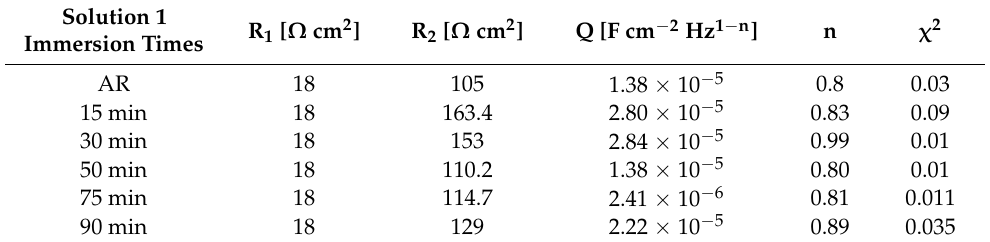
Table 6. Results of the fitting of the experimental data for the samples obtained with solution 1 at 50 ◦ C.